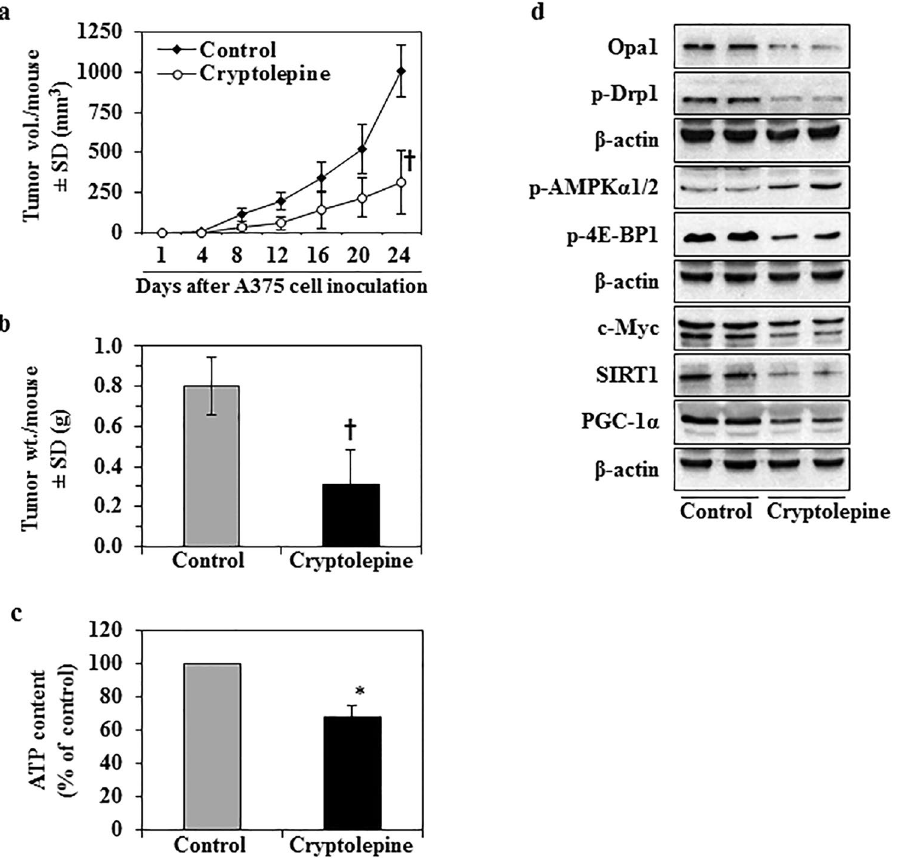
Figure 7. Cryptolepine treatment inhibits the growth of melanoma xenografts in athymic nude mice. The tumor xenograft growth experiment was carried out for a total of 24 d, as detailed in Materials and Methods. ( a) Tumor xenograft growth was monitored and is shown in terms of tumor volume/mouse as a mean ± SD (mm 3 ), n = 5/group. ( b ) At the termination of the experiment, tumors were harvested and the wet weight determined. ( c ) ATP content was determined in each tumor lysate sample, as described in Materials and Methods. The data are presented in terms of percentage of the non-cryptolepine-treated group and expressed as mean ± SD. * P < 0.05, † P < 0.001. (d) Levels of proteins associated with mitochondrial biogenesis/dynamics were determined in lysates of the excised A375 melanoma tumor xenografts by western blot analysis. Each sample per group was prepared by mixing the tumor tissues from 2–3 tumors from different mice. Equal loading of proteins was verified by stripping the membrane and reprobing with anti- β -actin